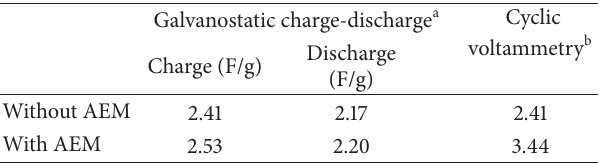
Table 2: Specific capacitances (F/g) of the CDP device flow system with a 60mL/min flow rate in 0.5 M NaCl electrolyte in the presence and absence of AEM. Galvanostatic charge-discharge a Cyclic voltammetry b Discharge Charge (F/g) (F/g) Without AEM 2.41 2.17 2.41 With AEM 2.53 2.20 3.44 a At a 0.45A/m 2 current density.